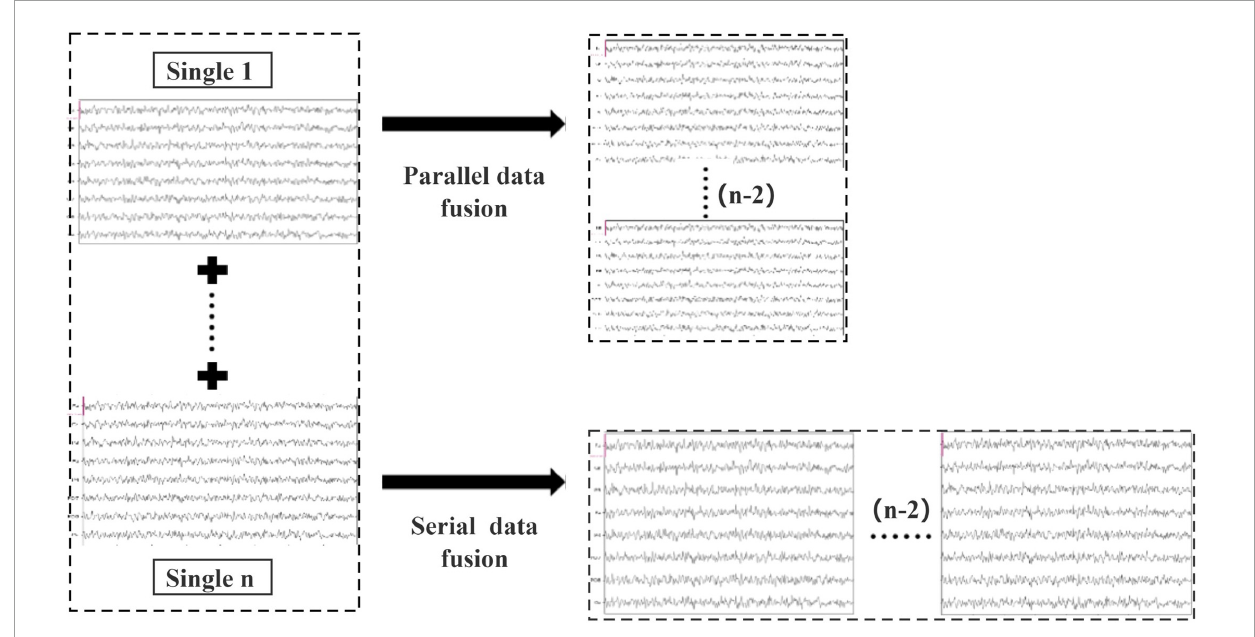
FIGURE3 Schematic diagram of parallel data fusion and serial data fusion of multi-person